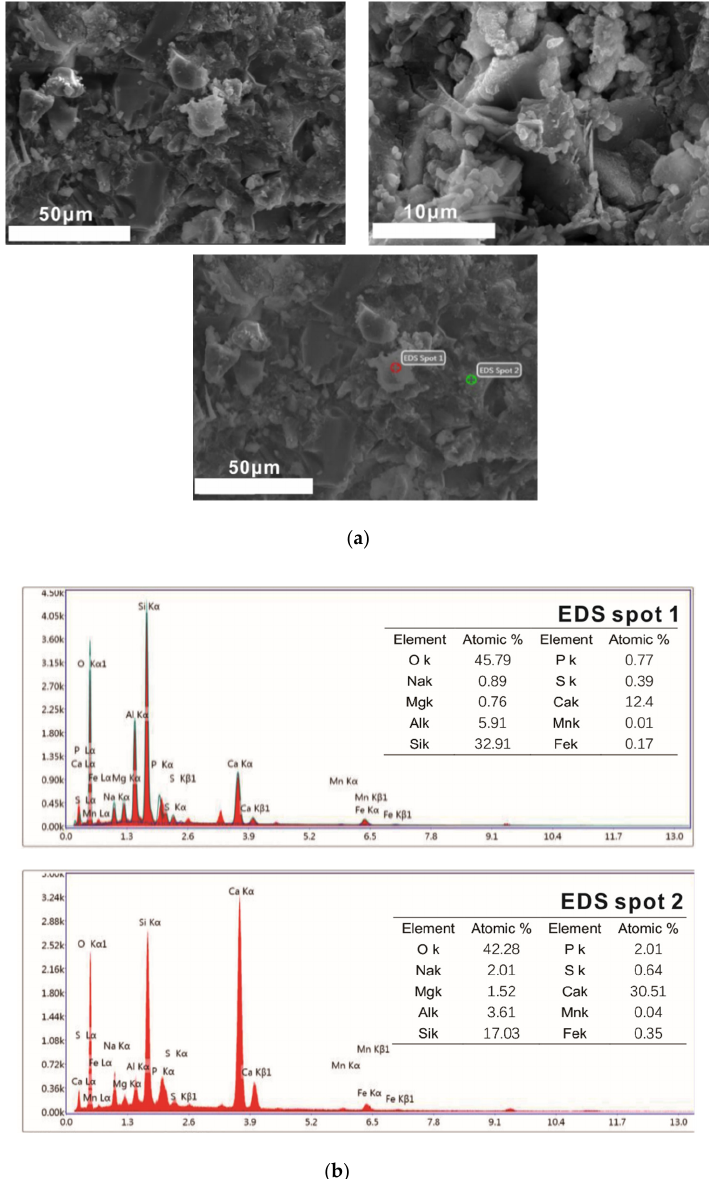
Figure 10. SEM-EDS images of 3 days of curing samples. ( a ) SEM images of 3 days of curing